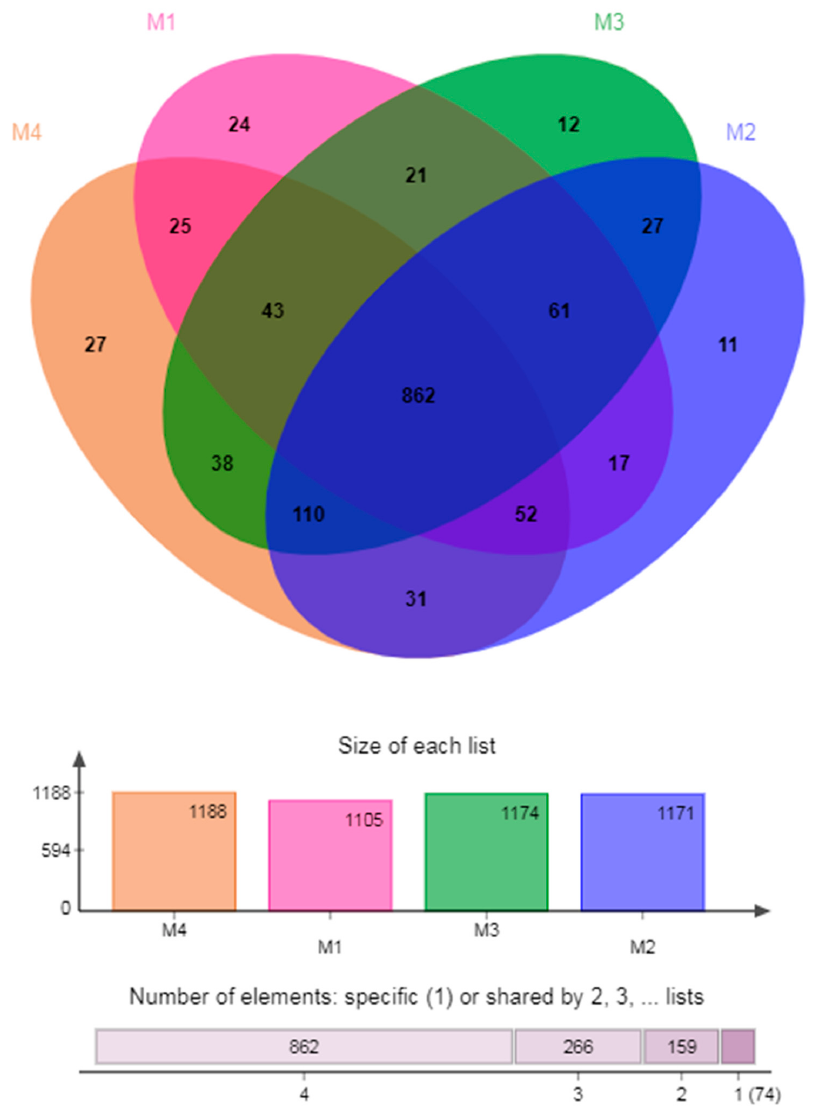
Figure 7. A Venn diagram of the operational taxonomic units (OTUs) for each sample.